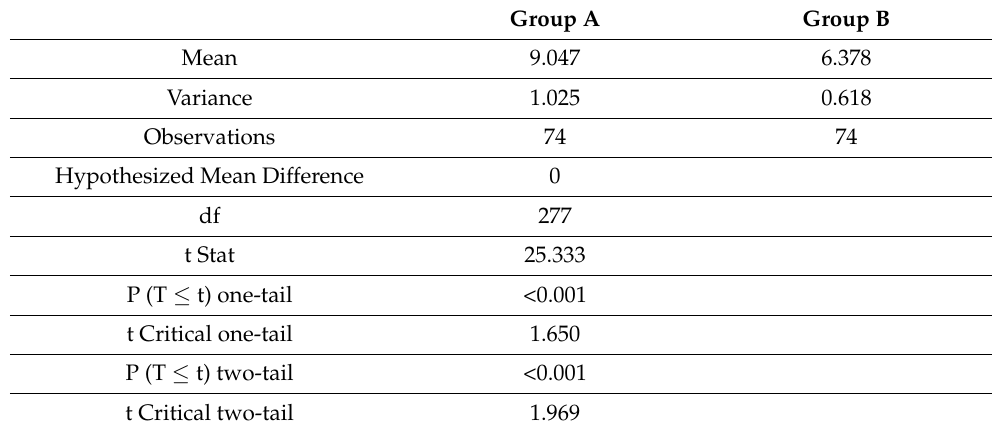
Table 6. t -test results of